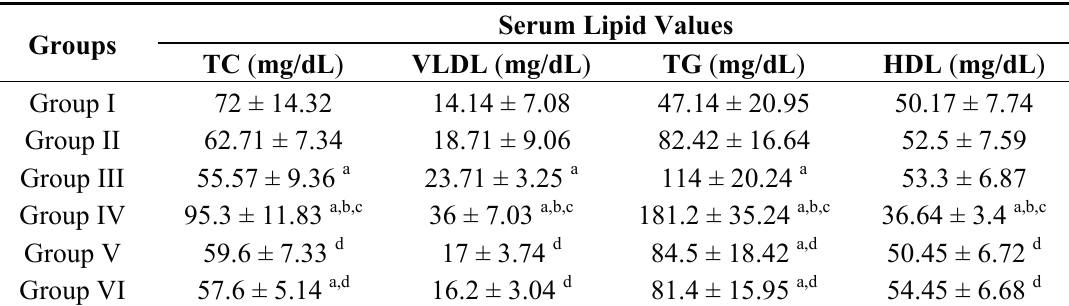
Table 4. Serum lipid